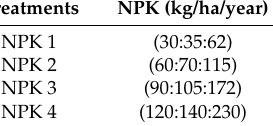
Table 1. Combination of Nitrogen (N), phosphorus (P), and potassium (K) (NPK) fertilizers rates.